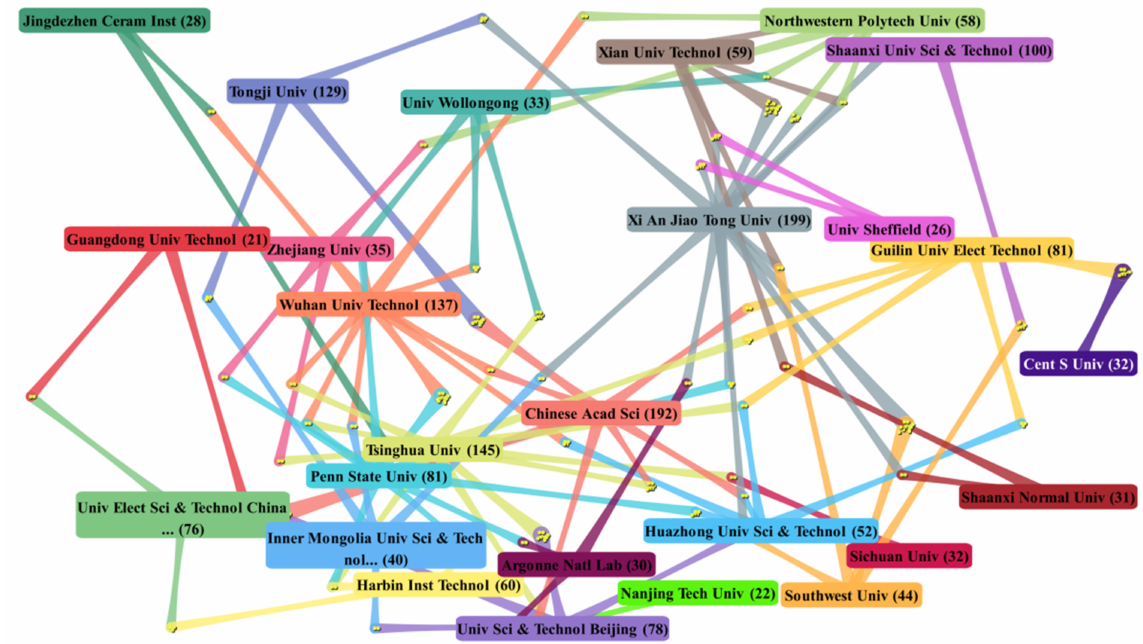
Figure 3. DDA cluster map on collaboration of the top 30 most productive institutions in energy storage ceramics